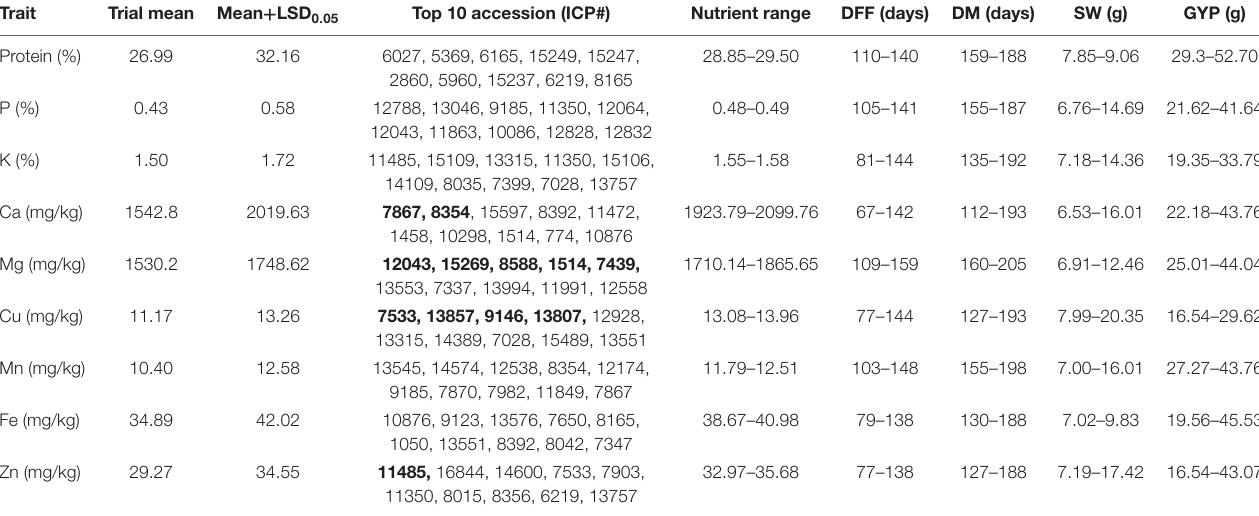
TABLE 3 | Top ten pigeonpea accessions with high trait value identified from 598 pigeonpea accessions evaluated during the 2019 and 2020 rainy seasons at ICRISAT, India. Trait Trial mean Mean + LSD 0 .